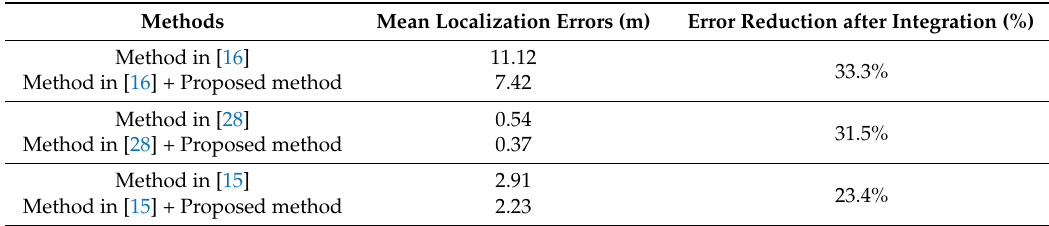
Table 4. Comparison of localization results with/without integration of the proposed method.